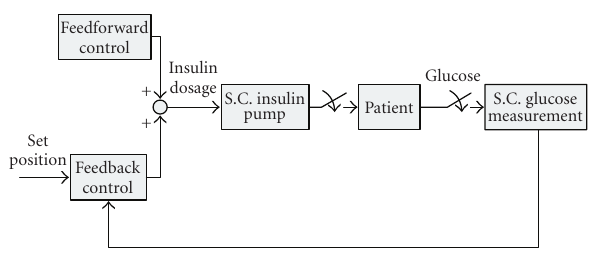
Figure 11: A control flow of partially closed-loop insulin therapy models from [15]. In general, in this case, insulin dosages are sup- ported by an expert system that generates an optimal insulin dosage from a comparison between a model case and a prediction of a fu- ture blood glucose